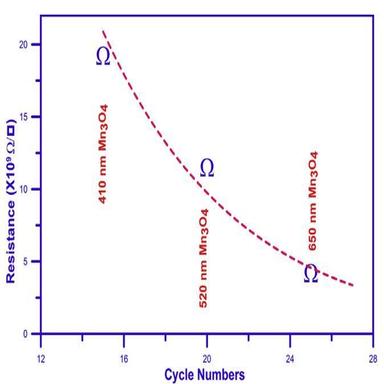
Electrical properties of the films were determined by resistance measurements. Sheet resistance decreases with increasing film thickness due to smaller grain boundaries.